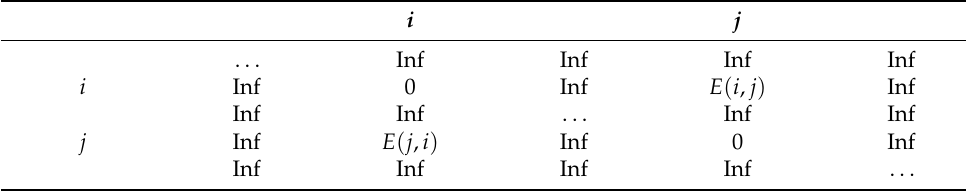
Table 5. The node matrix J with energy consumption